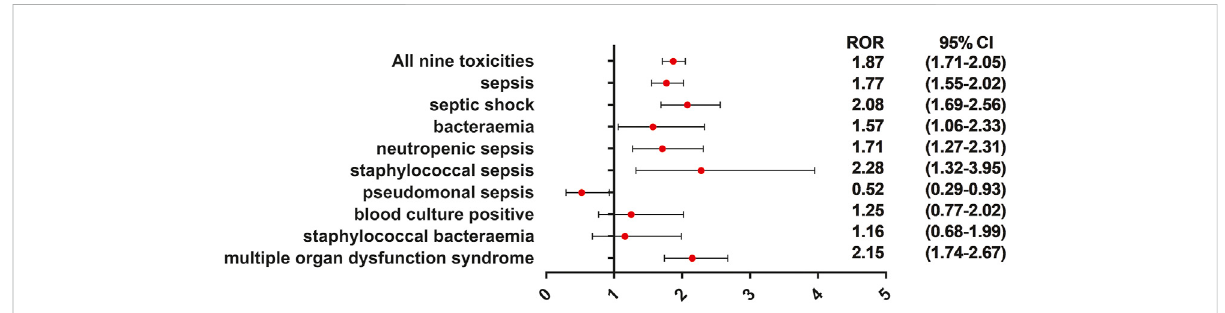
FIGURE 6 ROR of sepsis-related toxicities when males vs. females. This forest plot showed that sepsis, septic shock, bacteremia, neutropenic sepsis, staphylococcal sepsis, and multiple organ dysfunction syndrome were signi fi cantly more reported with males. This may provide alert of sepsis for clinicians when they are using ADC therapies to treat male cancer patients.